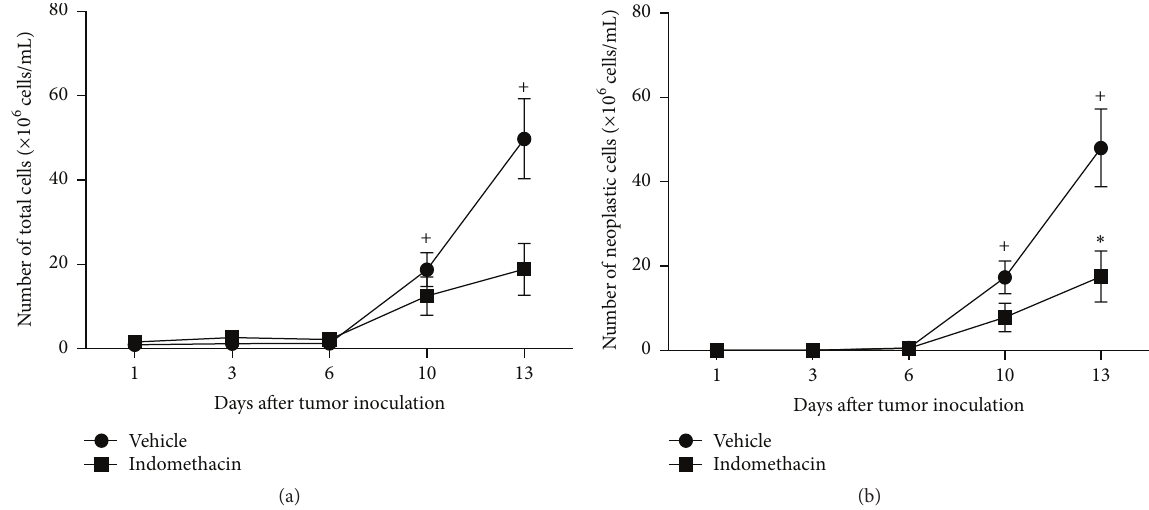
Figure 2: Graphs representing the number of total cells (a) and neoplastic cells (b) present in the peritoneal cavity 1, 3, 6, 10, and 13 days after inoculation of 10 3 EAT cells in mice treated with indomethacin (Indomethacin) or diluent (Vehicle). The groups consist of 6 to 21 animals. The graphs represent the median values obtained for the variables. 𝑃 values are provided as follows: +,∗ 𝑃 < 0.05 , when compared to prior time point in the same experimental group or to the other experimental group in the same time point,